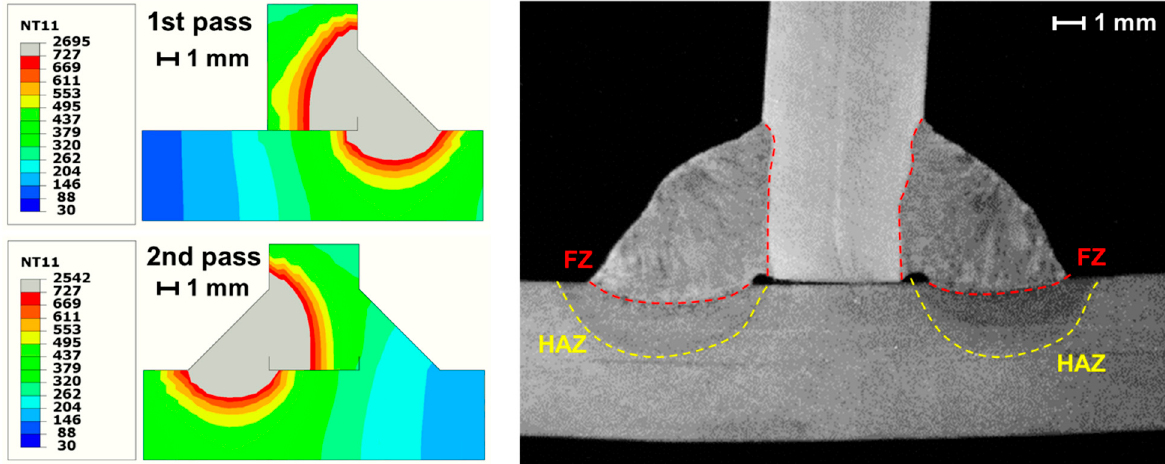
Figure 13. Numerical-experimental comparison of heat-affected zone (HAZ). FZ: fusion zone.